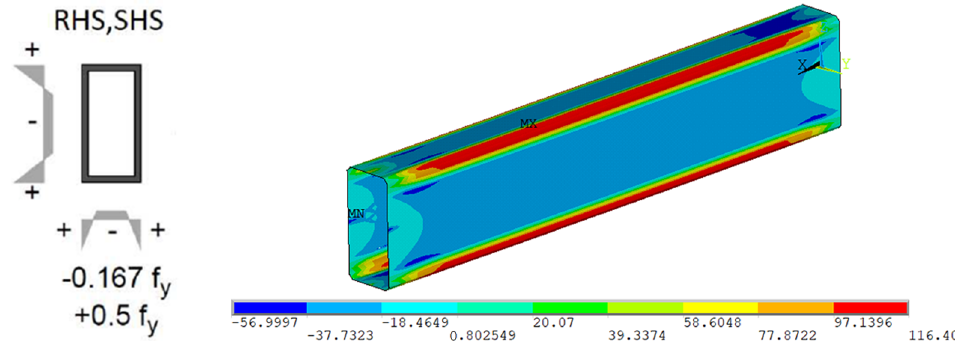
Figure 31. The distribution of residual stresses for members with RHS cross-section, fy = 235 MPa.